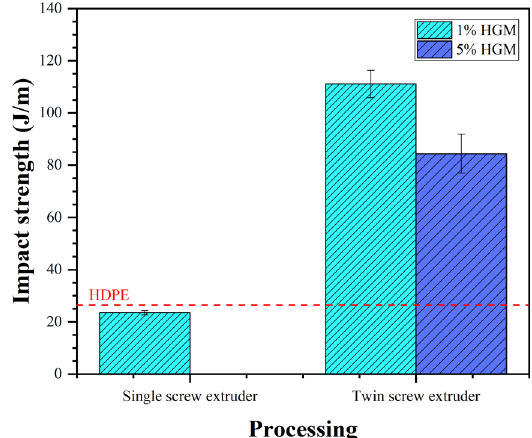
Figure 8. Impact strength of Syntactic Foams filler in the matrix. As for the elevation of HGM content, OZKUTLU; DILEK & BAYRAM (2018) 21 observed in their studies on syntactic PMMA/HGM foams that the